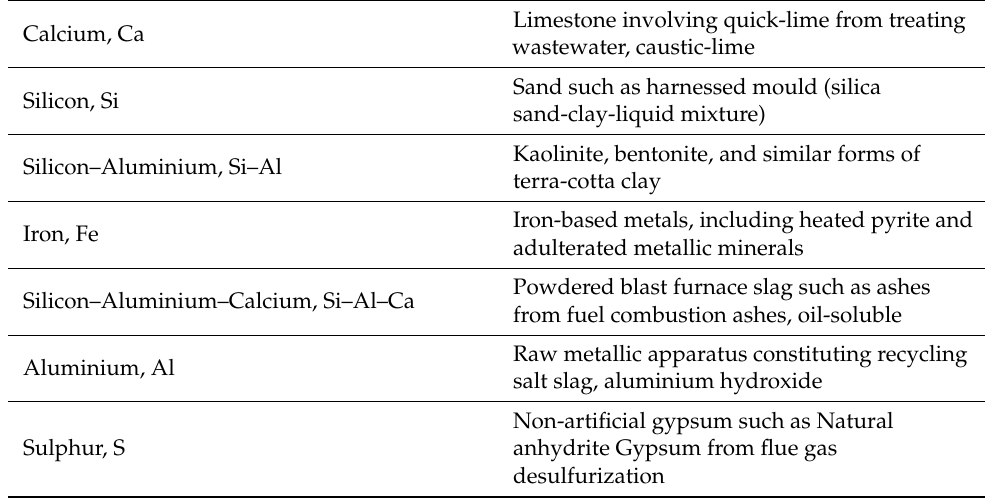
Table 1. Raw materials used for clinker